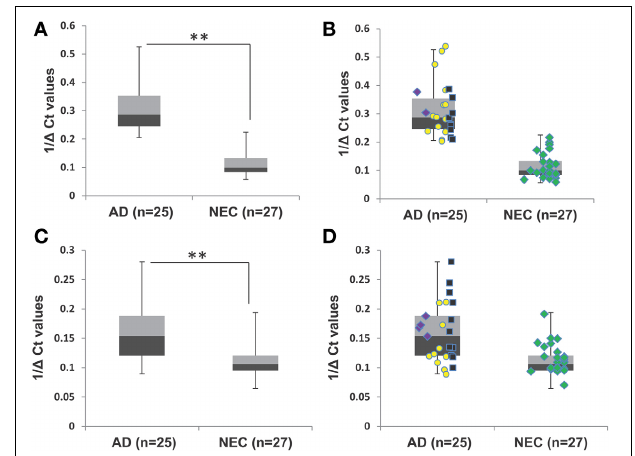
FIGURE 2 | Transcript levels of miR-34a and miR-34c in plasma samples of Alzheimer’s disease (AD) patients and normal elderly controls (NEC). (A) Comparison of plasma levels of miR-34c in the whole population of AD patients ( n = 78) with the NEC cohort ( n = 85). (B) Distributions of individuals’ levels of miR-34c along the box plot. NEC individuals were distributed in a close cluster around the median levels of the box plots, whereas AD specimens were distributed over a wider range with higher standard deviation. (C) Box plot representation of comparison in plasma levels of miR-34a in the whole population of AD patients ( n = 78) with the NEC cohort ( n = 85). (D) Individual miR-34a values along the box plot are less wide spread in the AD group as compared to those for miR-34c and a tight cluster for NEC is also observed. The data are plotted as inverse (cid:2) Ct derived from qPCR analysis. Data points of Mini-Mental Status Examination (MMSE) score ranges are: severe AD (score 4–9), moderate AD (score 10–20), mild AD (score 21–24), Table 2 | Plasma microRNA 1/deltaCt level ranges in Alzheimer disease (AD) patients and normal elderly controls (NEC) with standard deviation (SD) and median, for miR-34c and miR-34a in the whole cohorts.